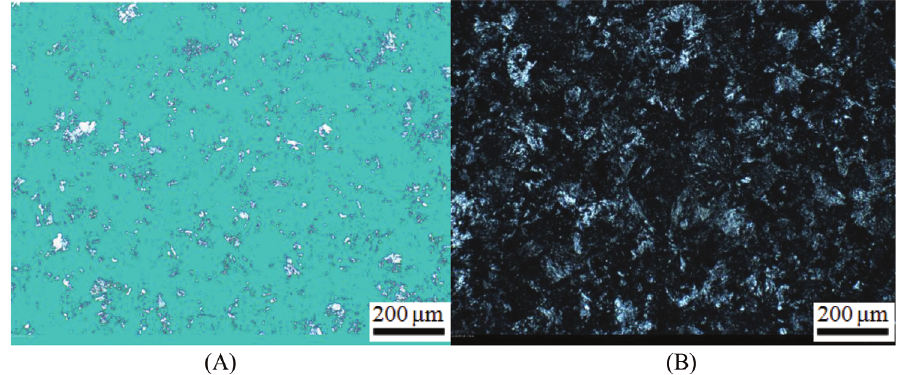
Figure 7: Carbide distribution before (A) and after (B) the image processing (the ultrasonic power of 500 W).